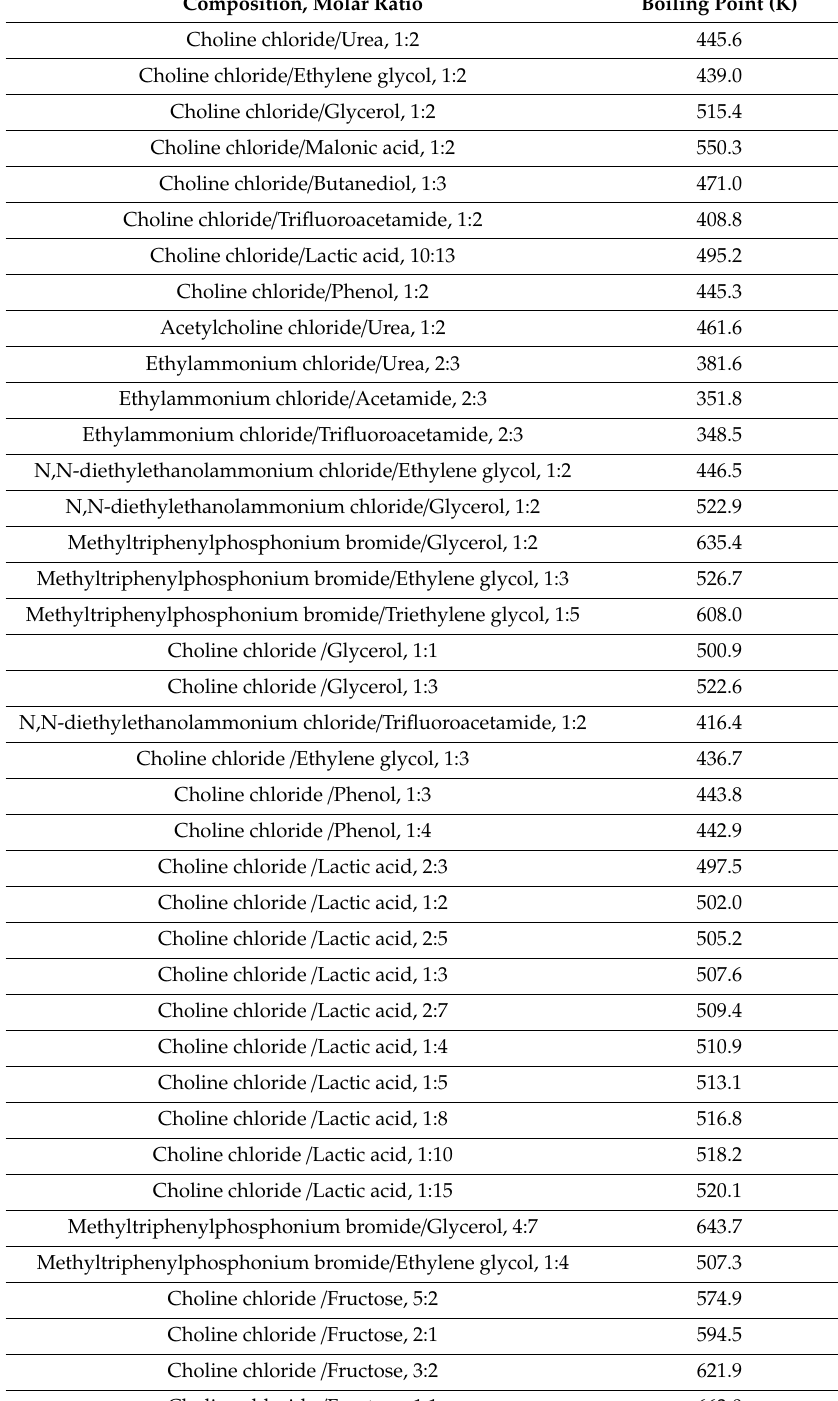
Table 6. Boiling points